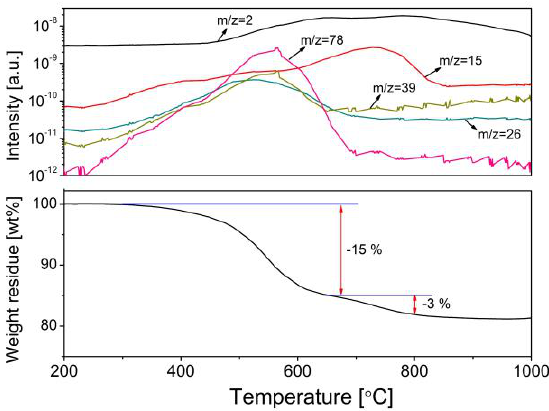
Figure 13. TG – MS curves of Si-containing preceramic polymers (polytitanocarbosilane) under a He atmosphere with a heating rate of 10 °C/min to a level of 1000 °C. Adapted from [55] with permission from Elsevier.